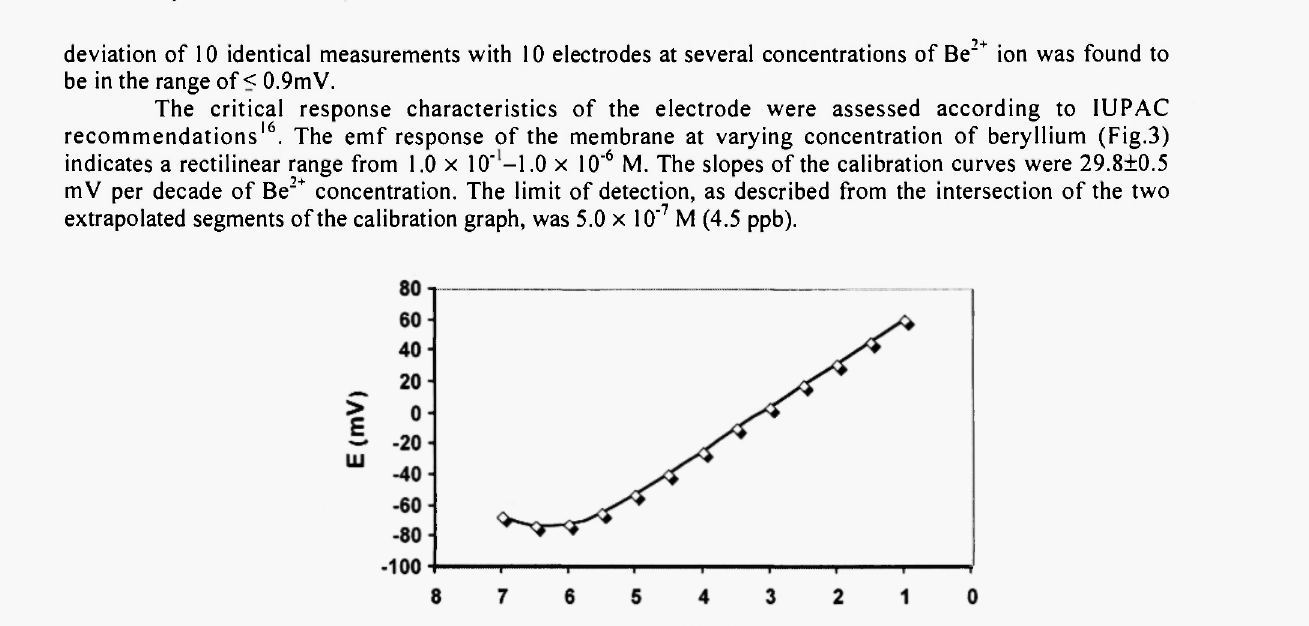
Fig. 3. Calibration curve for Be(II) sensor based on NHPC.